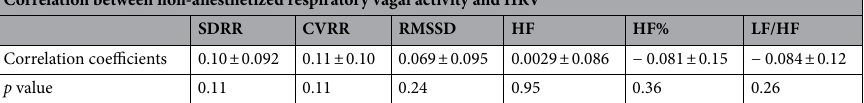
Correlation between non-anesthetized respiratory vagal activity and HRV SDRR CVRR RMSSD HF